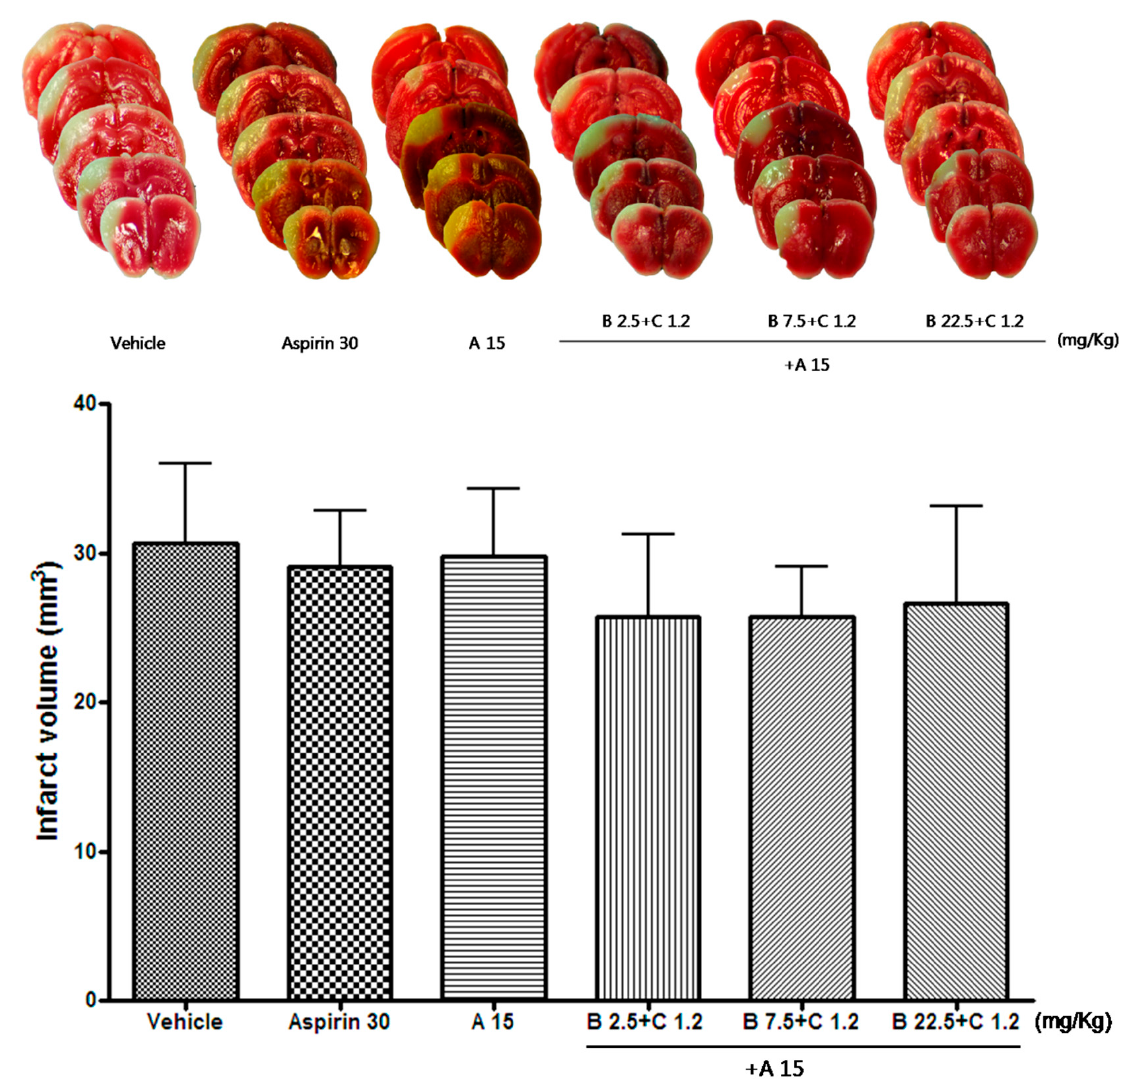
Figure 10. Effects of Sample A + B + C on ischemic brain injury after permanent middle cerebral artery occlusion (pMCAO). Infarct volume was measured 24 h after pMCAO. ( Upper ) Representative photographs of infarcted brain slices from vehicle- and ‘drug A + B + C’-treated mice. ( Lower ) There was no significant among-group difference in the cortical infarct volume after 24 h ( n = 8–10 mice for each group). Data represent means ± standard deviation. A, Chunghyuldan; B, ethanol extract of Radix Salviae Miltiorrhizae and Radix Notoginseng; C, Borneolum Syntheticum.